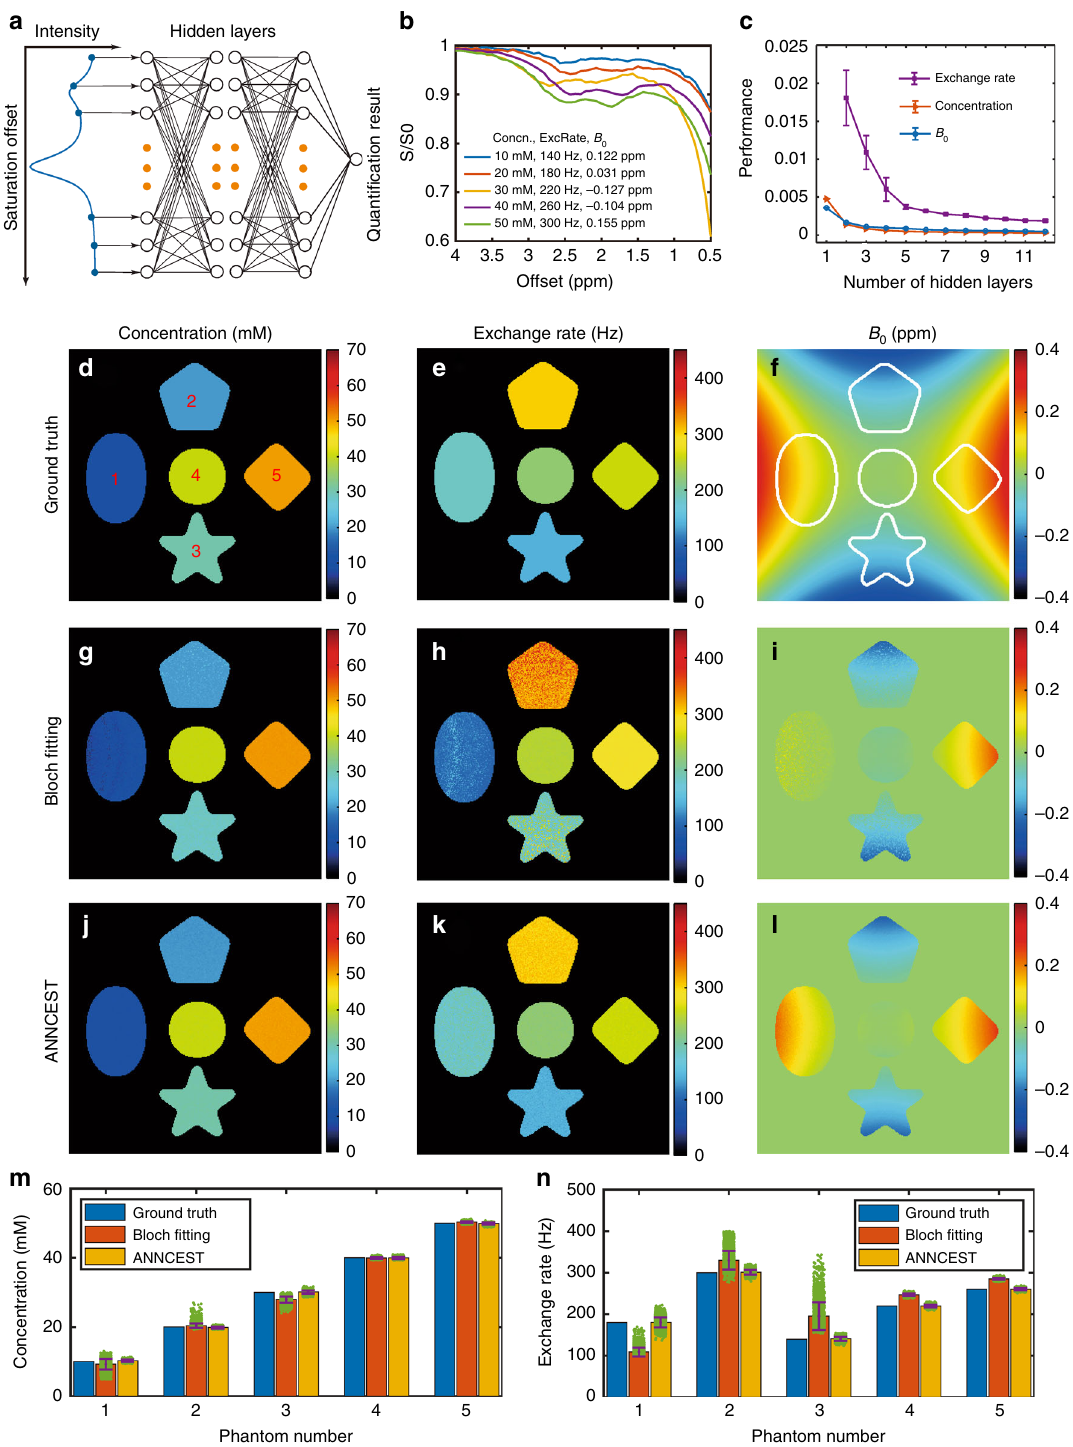
especially in vivo, where strong magnetization transfer contrast (MTC) exists. Here, CEST experiments with different saturation powers and saturation lengths were performed on human skeletal muscle to experimentally evaluate the PCr contrast on a 3 T clinical system. Due to the presence of MTC, the Z spectra of human skeletal muscle are quite different from those obtained on PCr phantoms (see Supplementary Fig. 1). From the optimization results for saturation powers ranging from 0.2 µT to 0.8 µT (Fig. 3a – d), the Z spectrum obtained with a relatively low